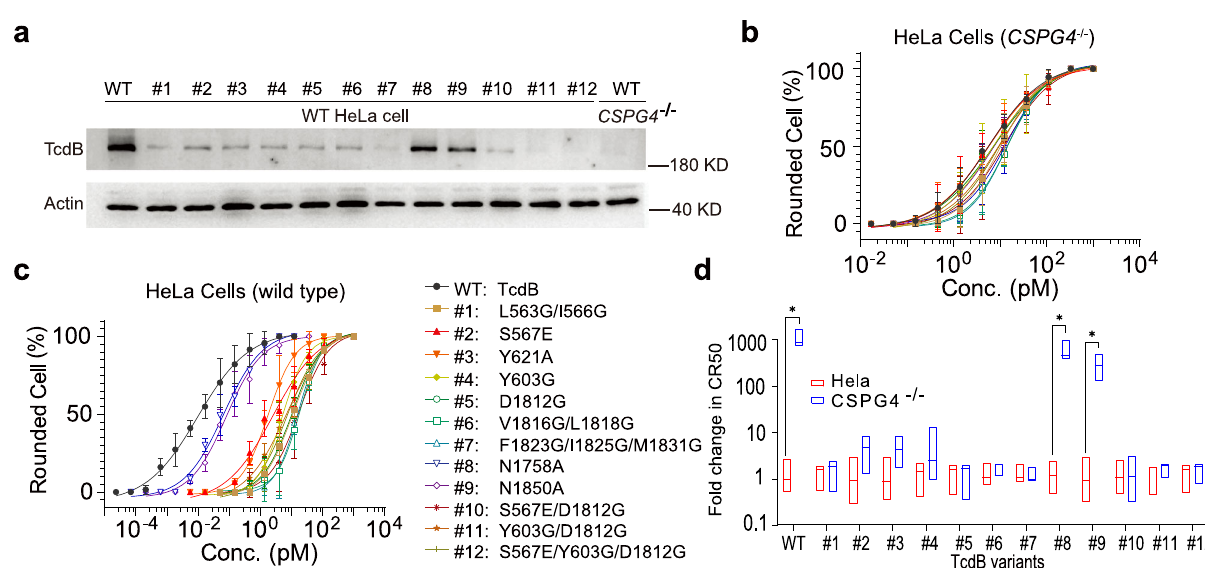
Fig. 3 Structure-based mutagenesis analyses of the interactions between TcdB and CSPG4. a The indicated TcdB mutants were tested for binding to cells. Puri fi ed WT and mutated TcdB (10 nM) were incubated with WT or CSPG4 − / − HeLa cells. Cells were washed three times by PBS, harvested, and cell lysates were analyzed by immunoblot detecting TcdB. Actin served as a loading control. The sensitivity of CSPG4 − / − ( b ) and WT ( c ) HeLa cells to mutated TcdB was examined using the standard cytopathic cell-rounding assay. Error bars indicate mean ± sd ( n = 3 biologically independent experiments). d The ratios of CR 50 values on CSPG4 − / − vs. WT HeLa cells from b and c were calculated and plotted, re fl ecting the fold-of-change in reduction of toxicity on CSPG4 − / − cells compared with WT cells. n = 3 for all groups. The upper and lower bounds of boxes indicate the maximum and minimum values of each group. The middle lines indicate the median values of each group. p values by t -test: * p ≤